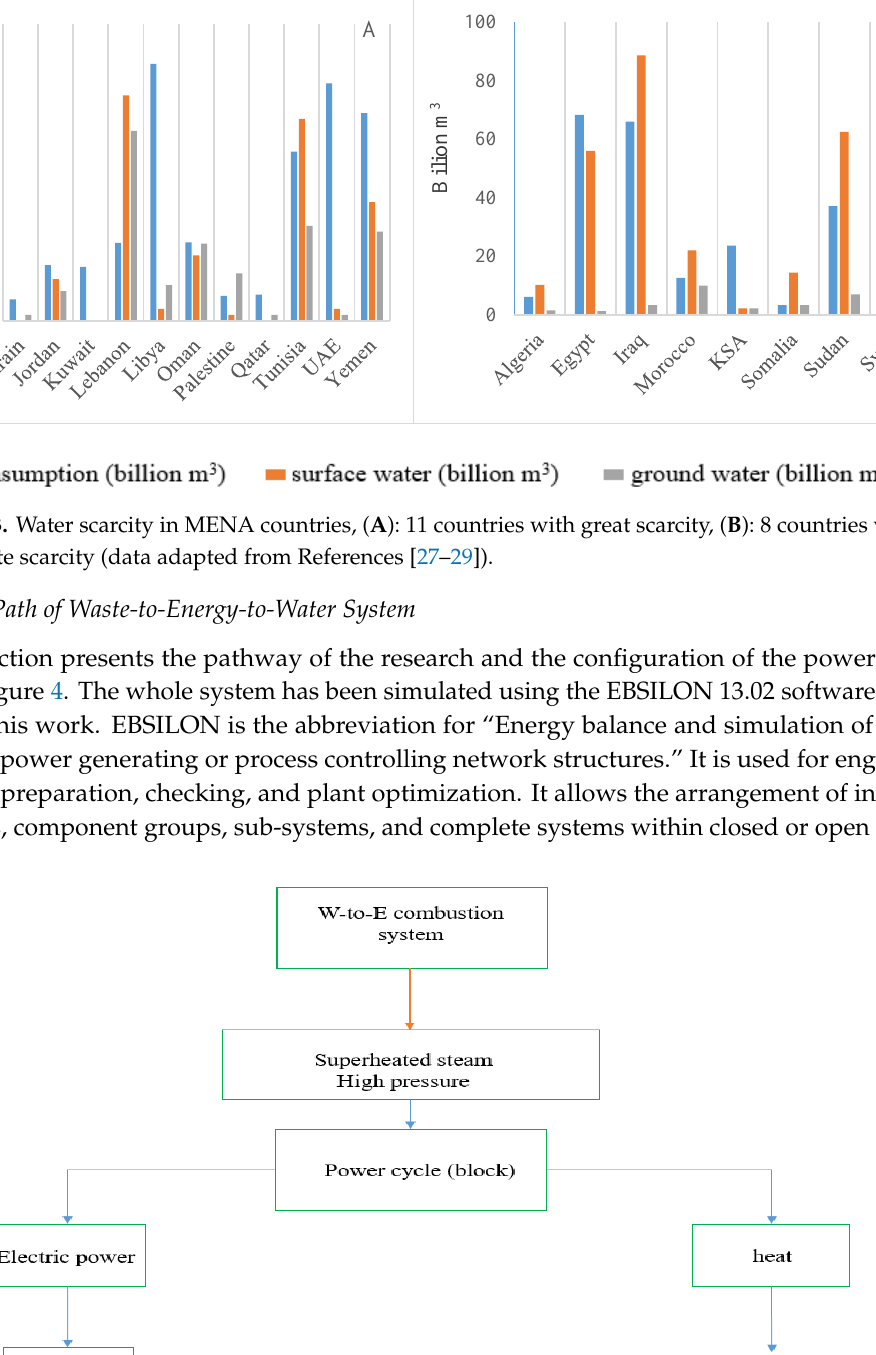
Table 3. Technical parameters for the main components in a power block.